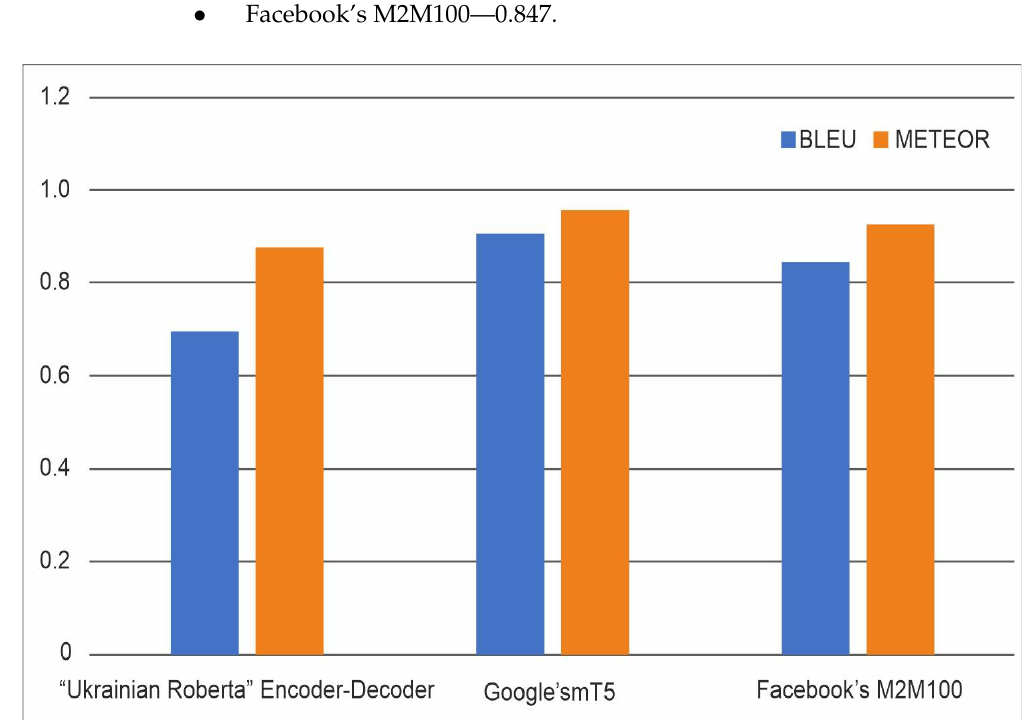
Figure 21. The results of applying the neural network.